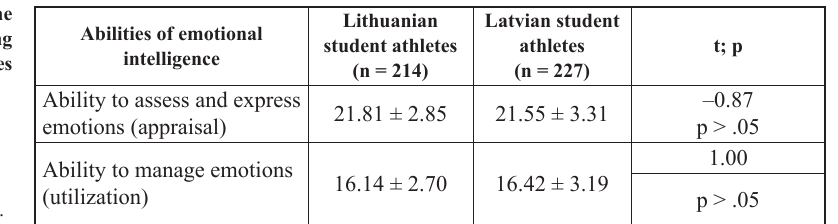
Note. M = mean; SD = standard